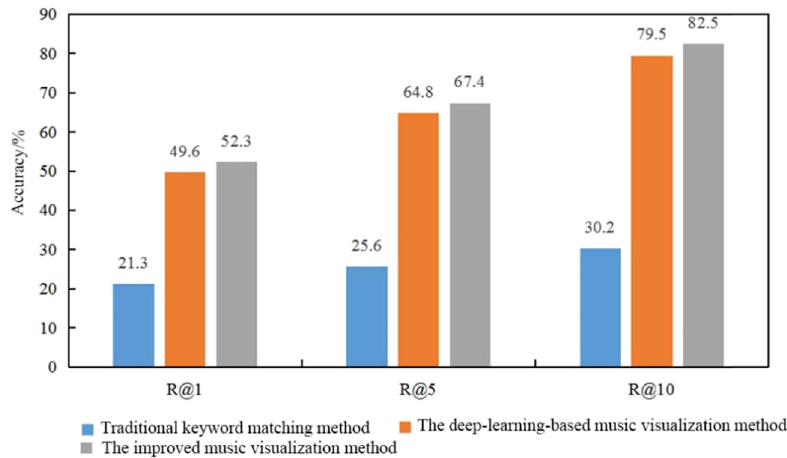
Figure 5: Matching accuracy of three music visualization